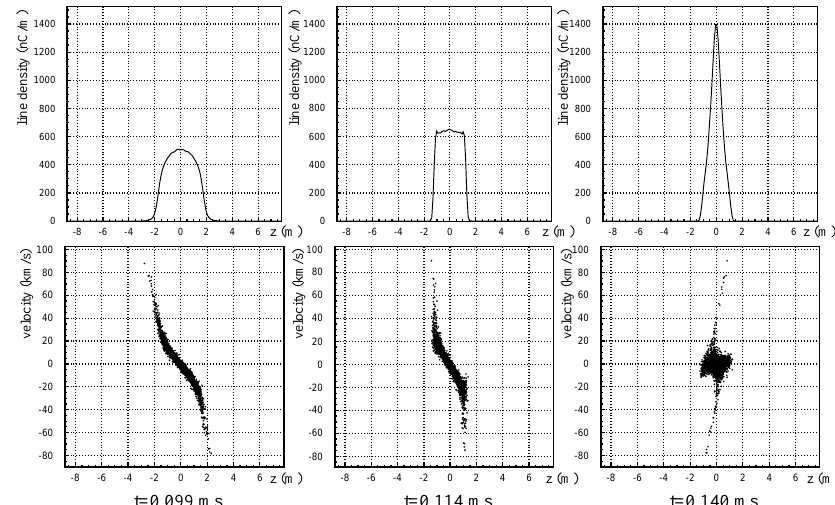
FIG. 10. Line density and scatter plot of longitudinal phase space for Gaussian bunch with h (cid:1) 2 0.005 .